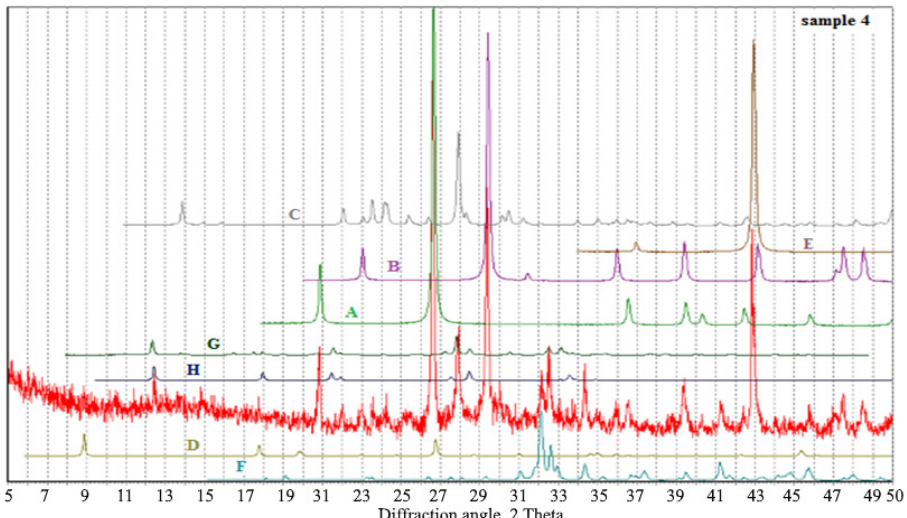
Figure 7. Diffraction pattern of the sample based on the aspiration dust from the electrostatic pre- cipitators. The crystal phases for comparison comprise: A—quartz, B—calcite, C—albite, D—mus- covite, E—magnesium oxide, F—larnite, G—analcime, and H—garronite.